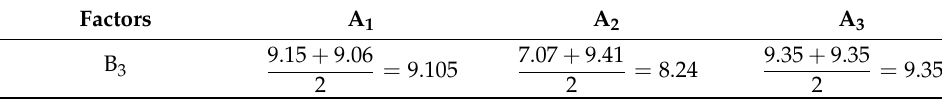
Table 3. Collocation of levels for factors A and